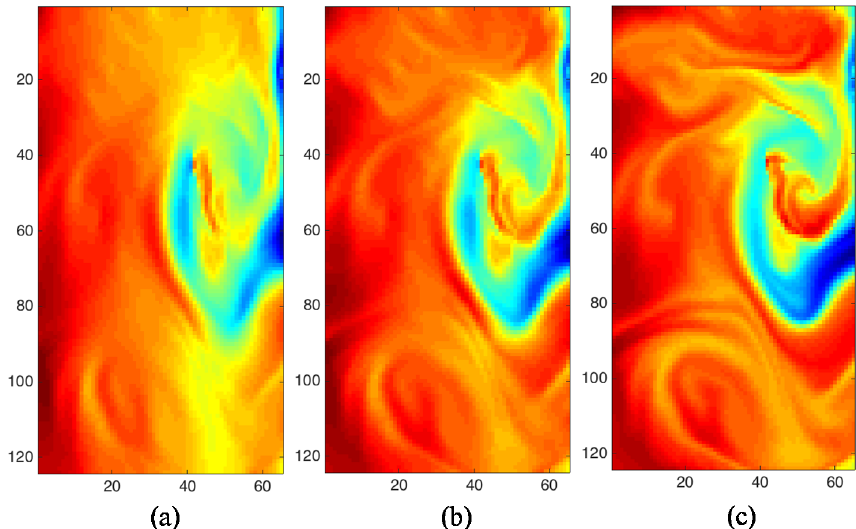
Figure 2. These three images represent the destriped versions of the image, shown in Fig. 1b, in three different ways. Panels (a) and (b) are obtained with α = 1 and α = 3 × 10 − 1 from the functional in Eq. (3). Panel (c) is obtained with α = 7 × 10 − 1 from the functional with spatially weighted regularization term, as shown in Eq.